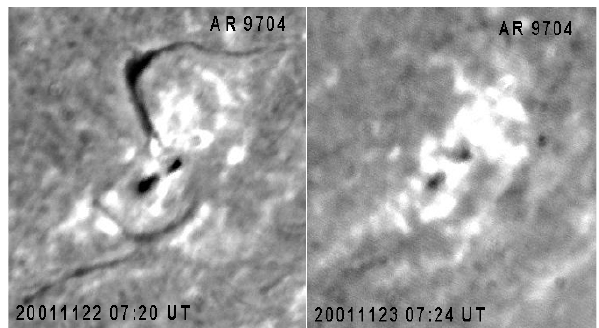
Fig. 3. H- α images (from Kanzelh¨ohe Observatory, http://www. solobskh.ac.at/) of the filament disappearance on 22–23 November (DOY 326–327), 2001. Fig. 4. MDI images showing the evolution of the magnetic con-